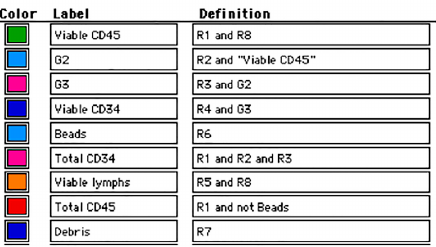
Figure 7. Gate definitions for BD Cell Quest software.